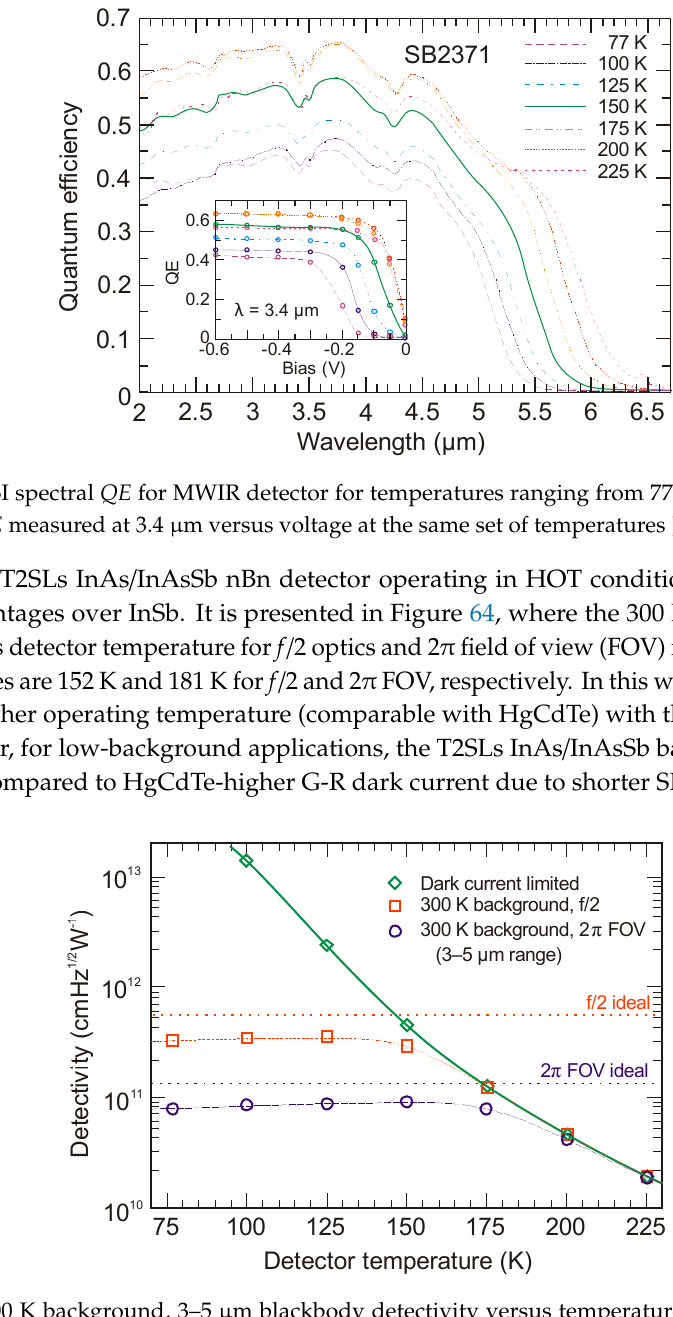
Figure 64. 300 K background, 3–5 μ m blackbody detectivity versus temperature for f /2 optics and 2 π FOV (dashed lines); the corresponding ideal D * values are indicated by dotted lines. The shot noise limited D * is also depicted (solid line) (after [171]).